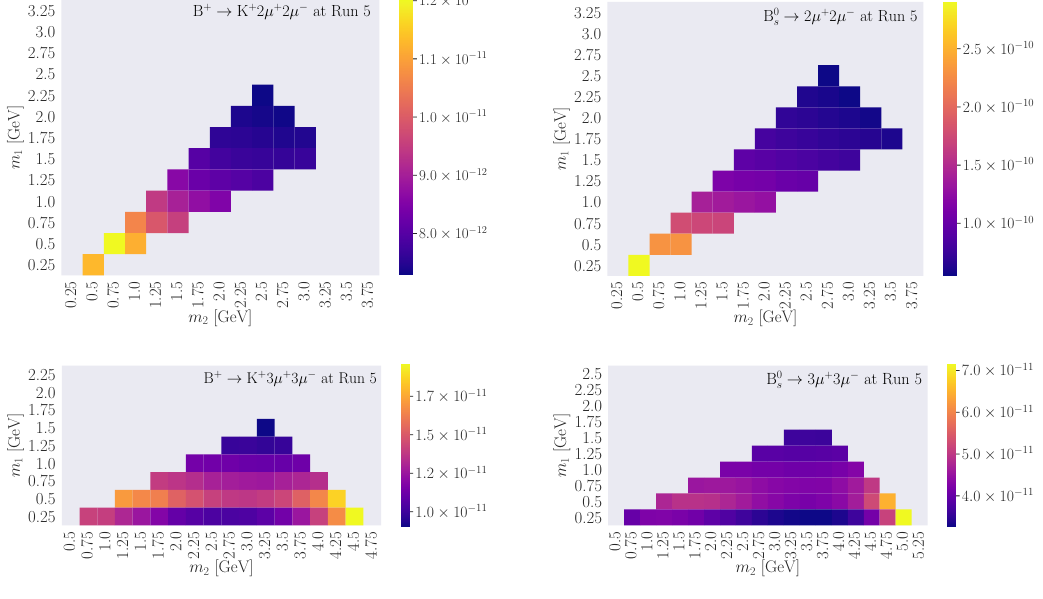
Figure 10 . Mass-dependent expected limits at Run 5 on the branching fractions of (top left) B + → K + 2 µ + 2 µ − , (top right) B 0 → 2 µ + 2 µ − , (bottom left) B + → K + 3 µ + 3 µ − and (bottom right) s B 0 → 3 µ + 3 µ − for a lifetime of the long-lived scalar of 100 ps . The top figures require that m 2 ≤ 2 m 1 . s The decays are reconstructed inclusively by requiring four muons as Downstream